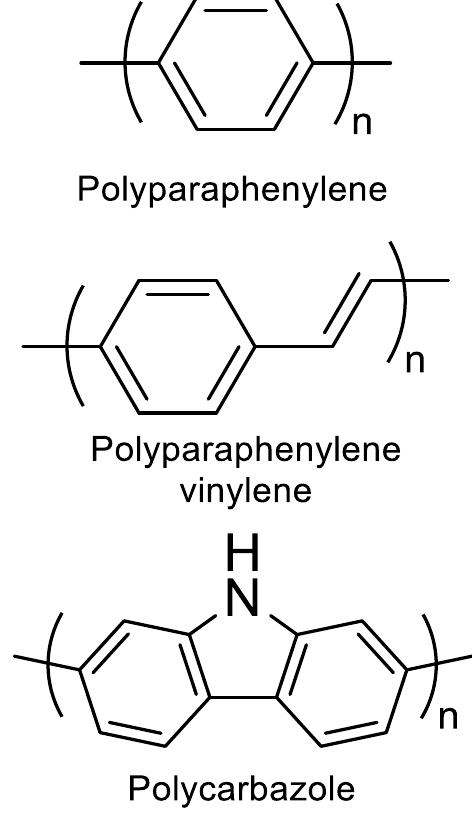
Figure 10. Classic examples of conducting polymers.